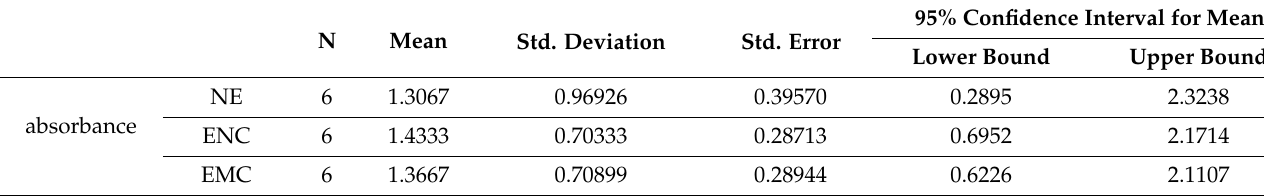
Table 3. Descriptive analysis through one way ANOVA.